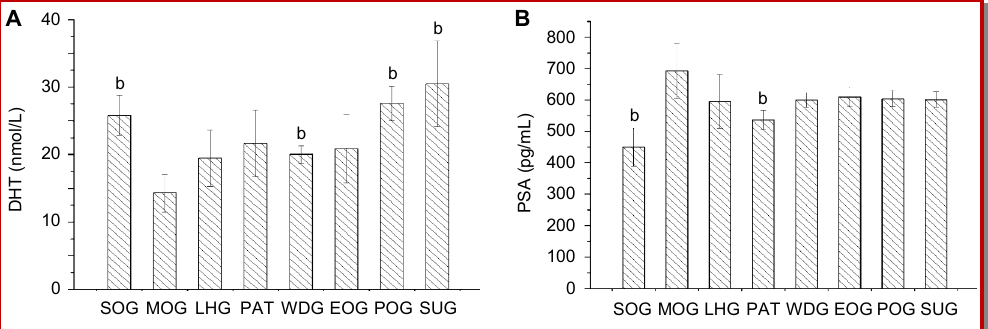
Figure 3: Effect of different constituents of T. patula on t he levels of serum DHT and PSA . Values are in mean ± SD; n = 8; a = p<0.05, b = p<0.01 Vs the model group